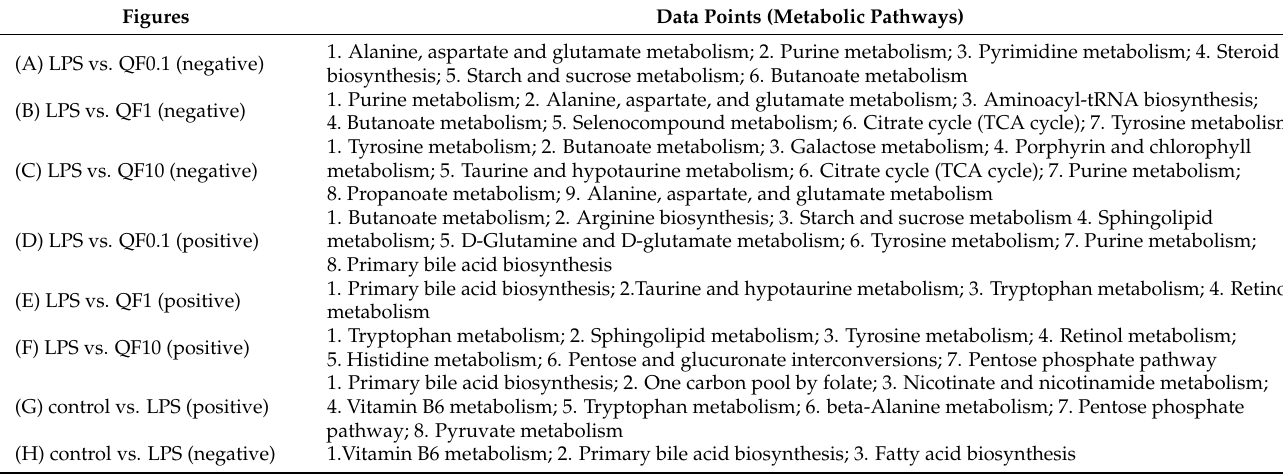
Figure 2. Negative OPLS-DA score map ( A ) and positive OPLS-DA score map ( B ). Table 1. Enrichment maps’ description of upregulated metabolic